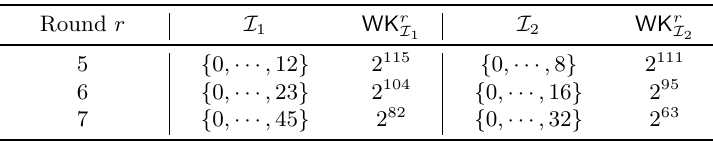
Table 4: Examples of weak